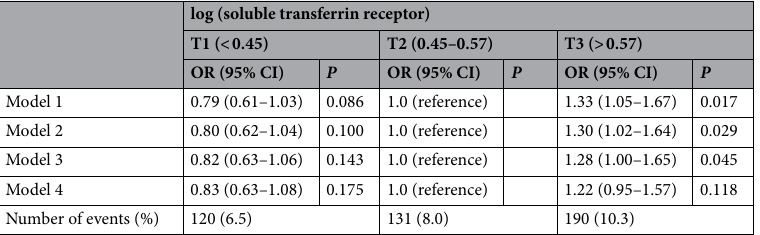
Table 3. Risk of a chronic kidney disease development according to tertile of log(soluble transferrin receptor). OR odds ratio, CI confidence interval. Model 1: unadjusted. Model 2: Adjusted for age, race, and education. Model 3: Model 2 + body mass index, serum hemoglobin, ferritin, and C-reactive protein. Model 4: Model 3 + diabetes mellitus, hypertension, cardiovascular disease, and